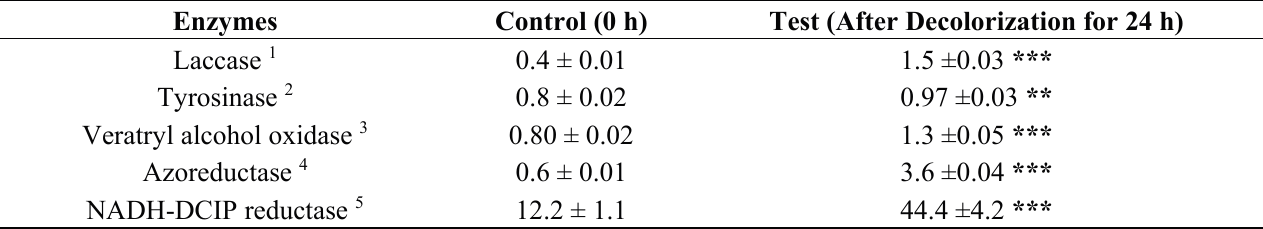
Control = Enzyme extracted after enrichment of microbial consortium. Test = Enzymes extracted from the dye decolorized culture medium. Values are mean of three experiments ± standard error mean (SEM), significantly different from control cells at * p < 0.05, ** p < 0.01 and *** p < 0.001 by one-way analysis of variance (ANOVA) with Tukey Kramer comparison test. 1 µM of ABTS oxidized min − 1 mL of enzyme − 1 mg of protein − 1 ; 2 µM of catechol oxidized min − 1 mL of enzyme − 1 mg of protein − 1 ; 3 µM of veratryl